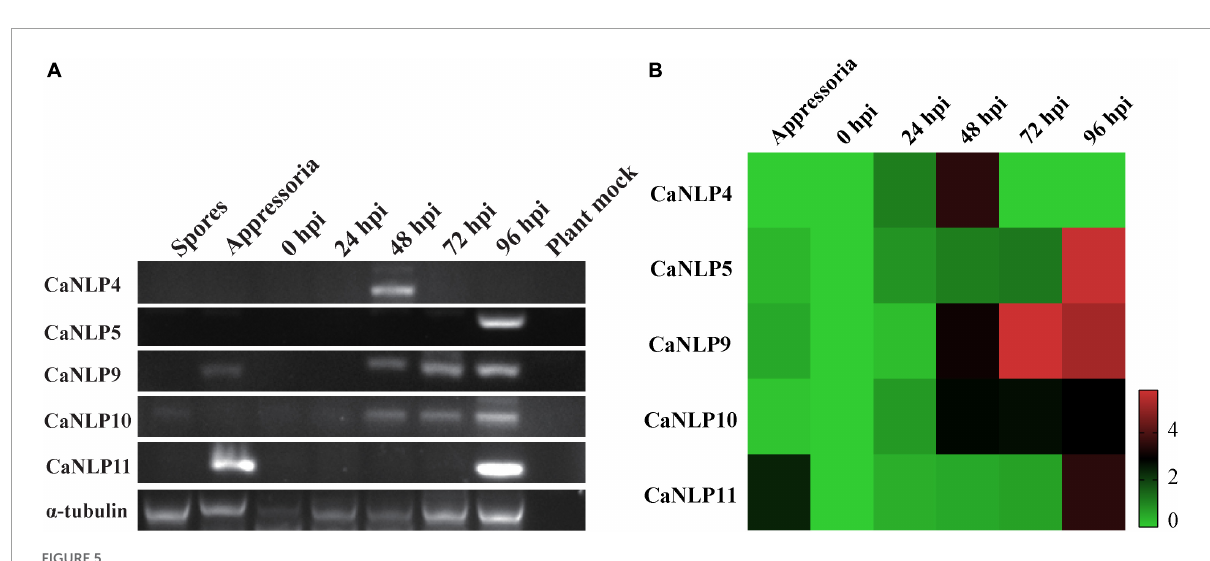
FIGURE5 Expression analysis of CaNLP. (A) Detection of five CaNLP transcripts at spore and appressoria stages, and at 0 h, 24 h, 48, 72, and 96 hpi. (B) The relative expression analysis of five CaNLPs was determined by qRT-PCR using tubulin as an internal reference gene. The heatmap representing fold (log 2 ) changes relative to spore